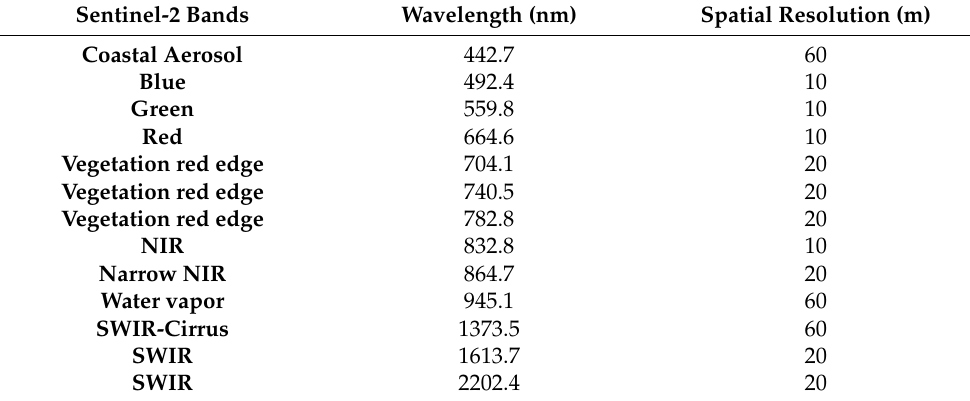
Table 2. Sentinel-2 satellite image characteristics.